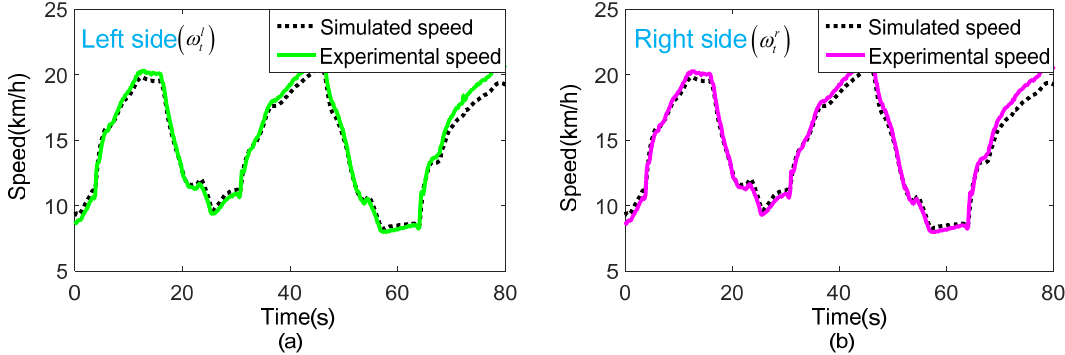
Figure 14 . Comparison of the actual speed obtained by the group 1 experiment and the simulation model with vehicle mass 20 t: ( a ) Left side actual speed; ( b ) Right side actual speed.